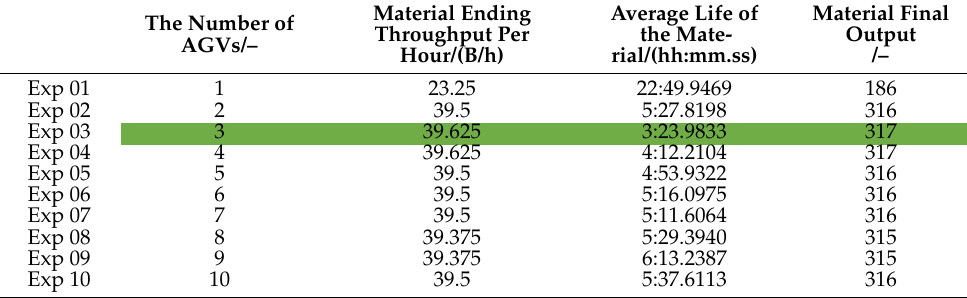
Table 9. Multi-level experiments for AGV quantity.